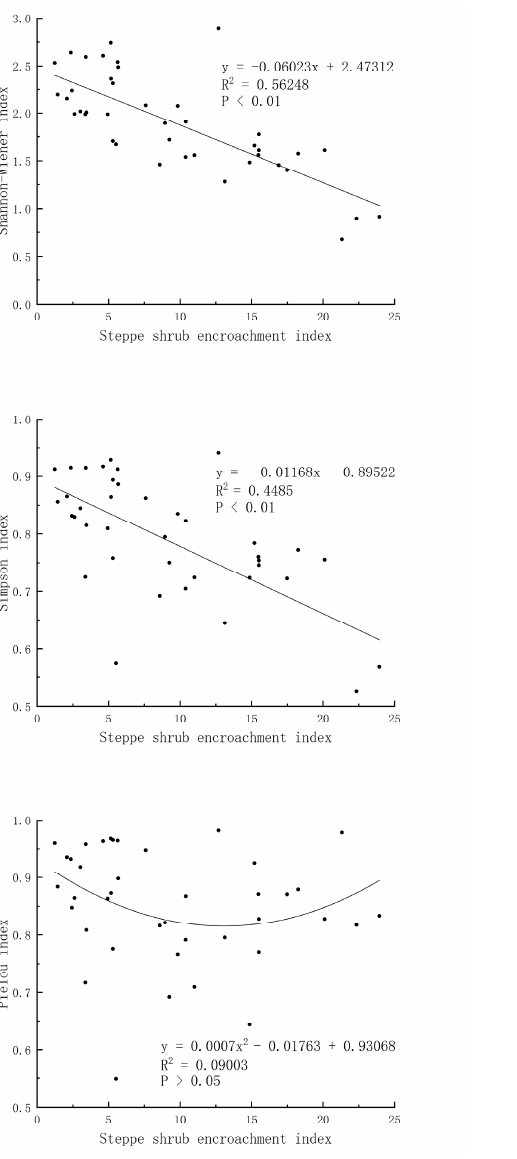
Figure 3. Relationship and difference in species diversity of herb communities at different shrub-level sites. Different lowercase letters indicate significant differences among sites ( p < 0.05) .